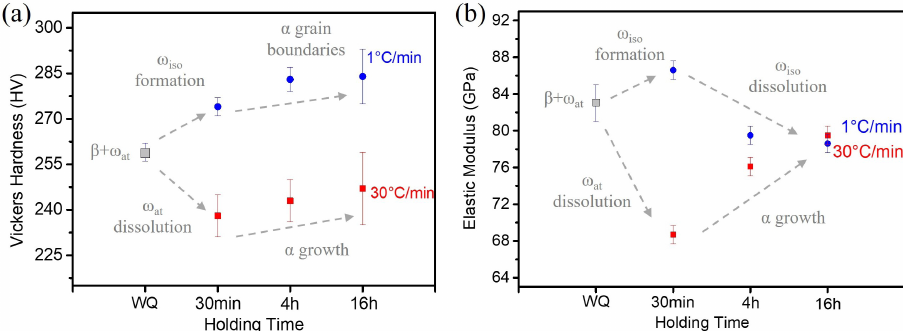
Figure 7. (a) Vickers hardness and (b) elastic modulus of each of the aged samples heated to 500 ºC at heating rates of 30 and 1 ºC/min for 30 min, 4 h, and 16